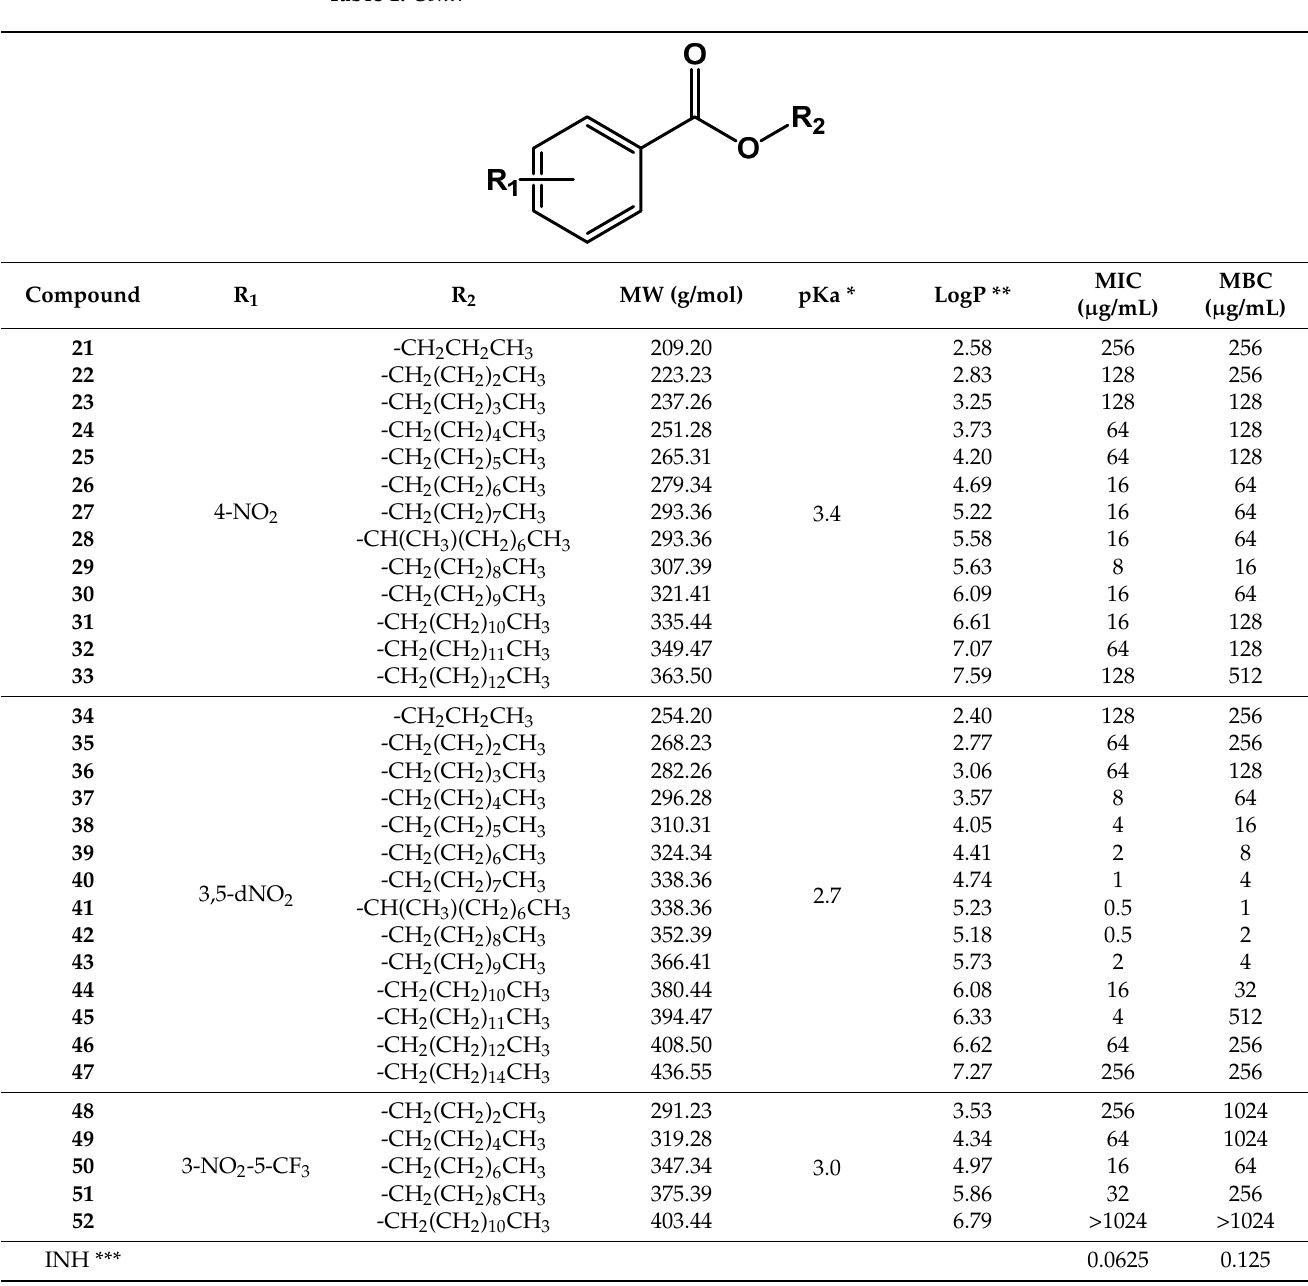
Table 1. Structure, physical properties and antitubercular activity of benzoate esters against Mtb Table 1. Cont .